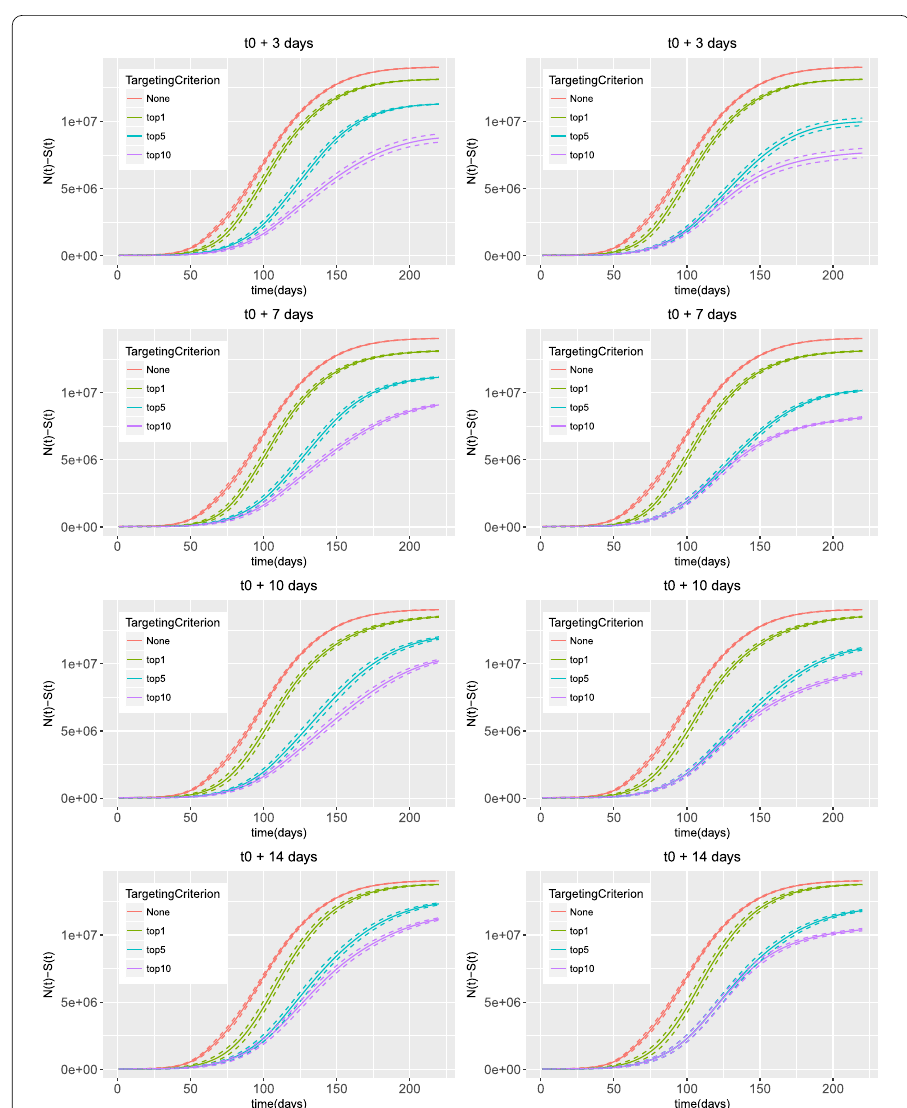
Figure 2 Performance of sub-prefecture-level isolation based on two different strategies for determining targeted sub-prefectures, centrality-based (a), place rank-based (b). Solid lines represent the average number of infections over the time, dashed lines are the 95% confidence interval. Interventions initiate three, seven, ten, fourteen days after the infection starts (i.e., t0)